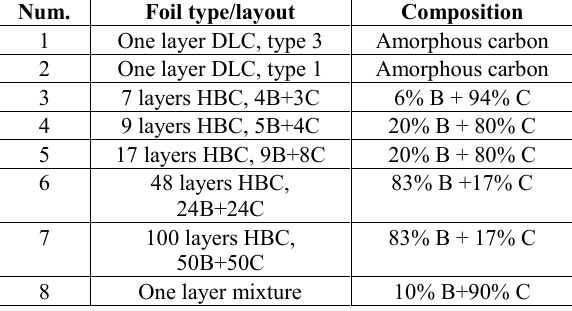
Table 1. Types of the foils. The nominal thicknesses were between 2-2.5μm (around 500 μg/cm 2 ), except the 10% boron mix 90% carbon monolayer foil, which thickness is